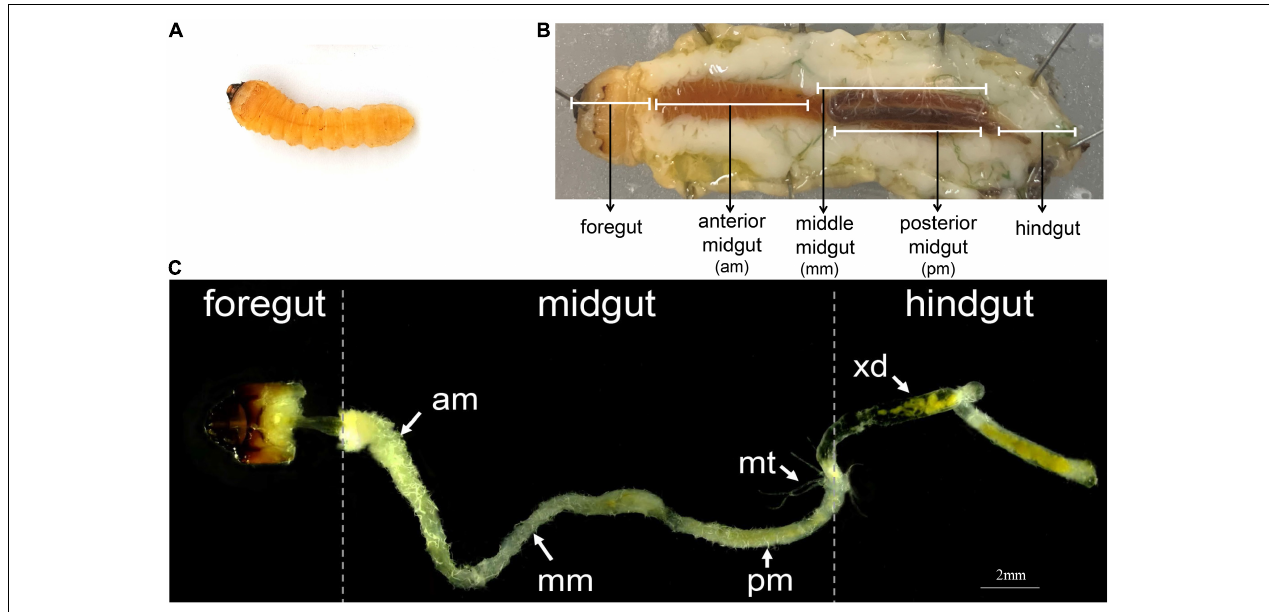
FIGURE 1 | The digestive system of A. glabripennis larvae. (A) Second instar larvae, (B) Schematic diagram of the digestive system of A. glabripennis larvae during dissection. The division of the midgut refers to Mason et al. (2017). (C) Gut morphology of A. glabripennis larvae, separated into anterior midgut (am), middle midgut (mm), posterior midgut (pm), malpighian tubules (mt), xylem debris (xd).